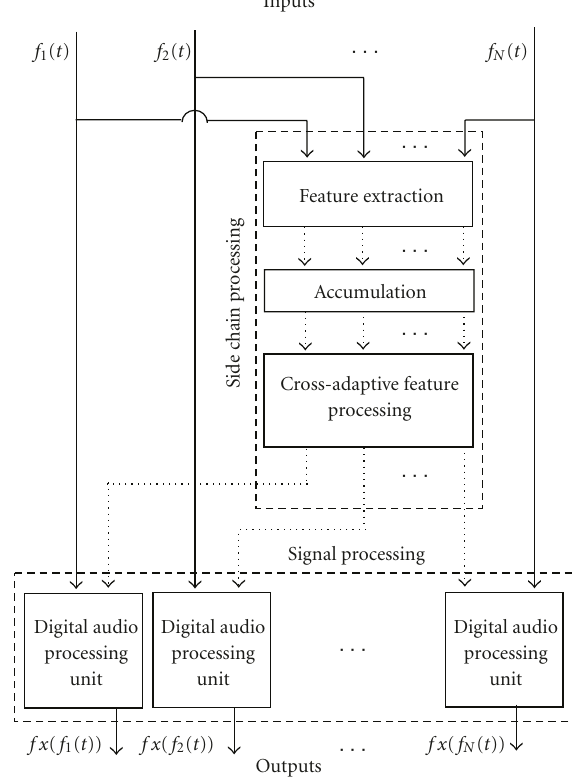
Figure 1: General diagram of a cross-adaptive device using side chain processing with feature